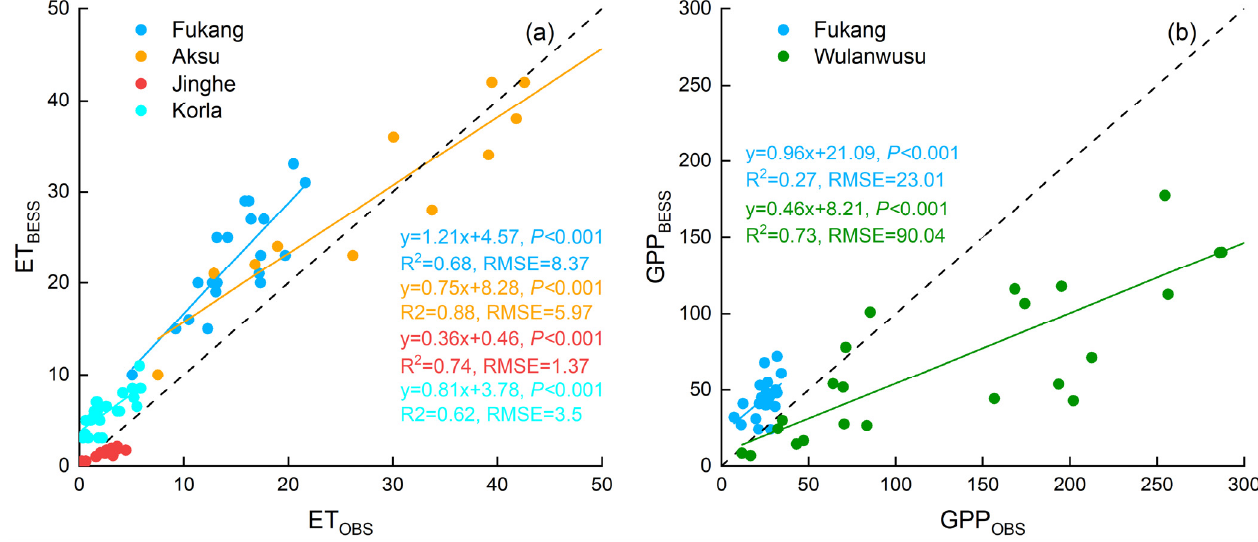
Figure 13. Relationship between observed data and the BESS model in Xinjiang. ( a ) The comparison between ET OBS and ET BESS ; ( b ) the comparison between GPP OBS and GPP BESS